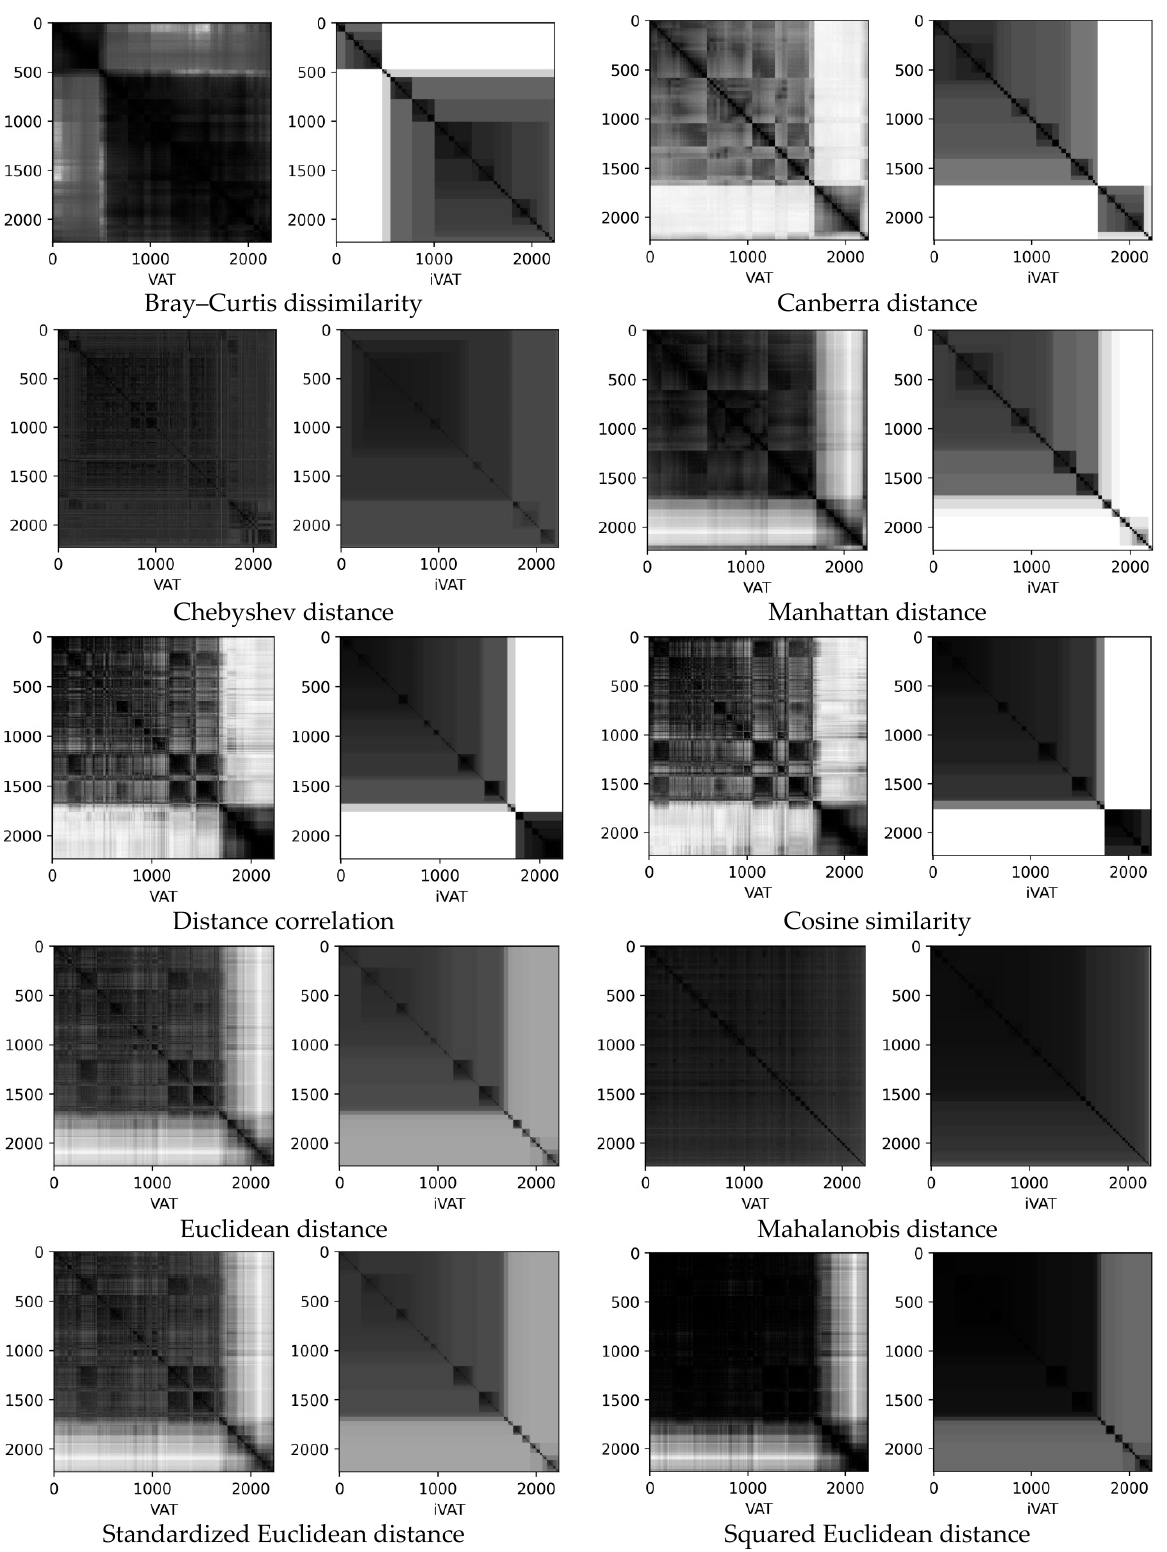
Figure A9. Irbey forestry. Cluster heat map.